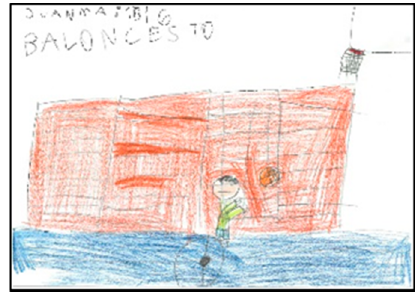
Figure 9. Represented space. Juanma. 1°B.